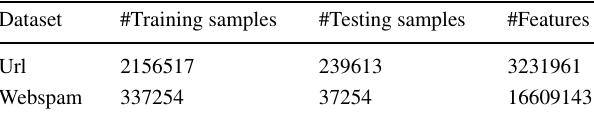
Table 3 A summary of datasets Dataset